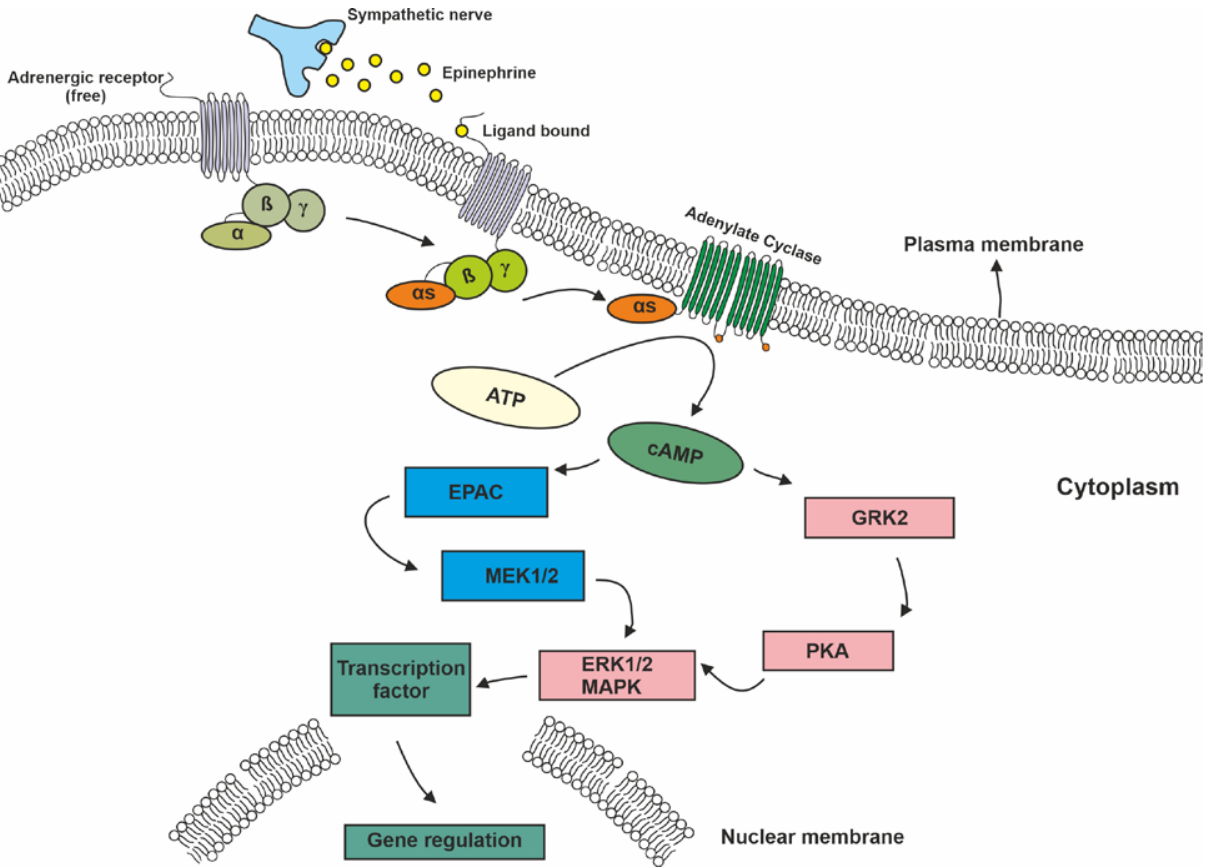
Figure 1. Main pathways of ß-adrenergic signaling . The figure above schematically depicts what pathways are involved in carrying signals to the nucleus upon engagement of catecholamine ligands with their adrenergic receptors. (Abbreviations: cAMP, cyclic AMP; PKA, proteinase K; GRK2, adrenergic beta receptor kinase; EPAC, guanine nucleotide exchange protein; ERK1/2, extracellular signal-regulated kinase; MEK1/2, mitogen activated protein kinase kinase 1/2).